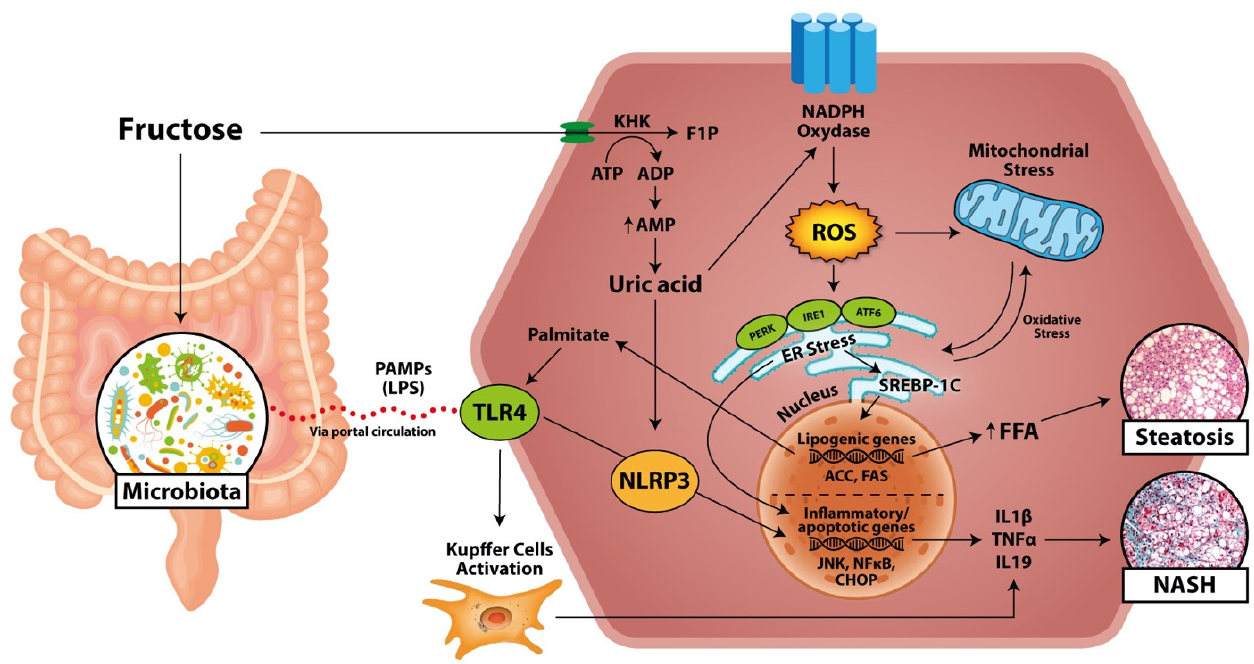
Figure 3. Fructose pathway involved in oxidative stress and inflammation. In the hepatocyte, fructose sugar is rapidly metabolized by KHK, depleting ATP and resulting in uric acid accumulation. Uric acid activates NADPH oxidase with production of ROS, which activates mitochondrial ROS production and stimulates UPR in ER. ER stress may also activate mitochondrial ROS production and vice versa. Moreover, ER stress contributes to progression of hepatic steatosis activating lipogenic genes via PERK, ATF4, and IRE1 and inducing SREBP-1c that increases the activity of ACC and FAS. As a response of excessive oxidative stress, inflammatory and apoptotic pathways are activated through JNK, NFkB, and CHOP, resulting in an increased production of cytokines (IL1ß, TNFa, IL19), which plays an important role in the development of NASH. Fructose consumption may alter GUT microbiota and intestinal permeability, increasing endotoxin translocation of, for example, LPS, the most common PAMPs, into the liver via portal circulation. PAMPs may activate TLR4 that promotes the Kupffer activation and, subsequently, inflammatory pathways. Altered lipid homeostasis and fatty acids such as palmitate, in which production is promoted by fructose, may activate TLR4. TLR4, but also the excess of fat, activate the inflammasome involved in production of inflammatory cytokines. ACC, Acetyl-CoA carboxylase; ATF4, activating transcription factor 4; CHOP, CCAAT/enhancer-binding homologous protein; IRE1, inositol-requiring signaling protein 1; IL, interleukin; FAS, fatty acids synthase; JNK, c-Jun N-terminal kinase; KHK, ketohexokinase; FFA, free, fatty acids; LPS, lipopolysaccharide; NASH, non-alcoholic steatohepatitis; NFkB, nuclear factor kB; NLRP3, PAMPs, pathogen-associated molecular patterns; PERK, protein kinase RNA-like ER kinase; SREBP1c, sterol regulatory element-binding protein 1c; TNF α , tumor necrosis factor alfa; TLR4, toll-like receptor 4.